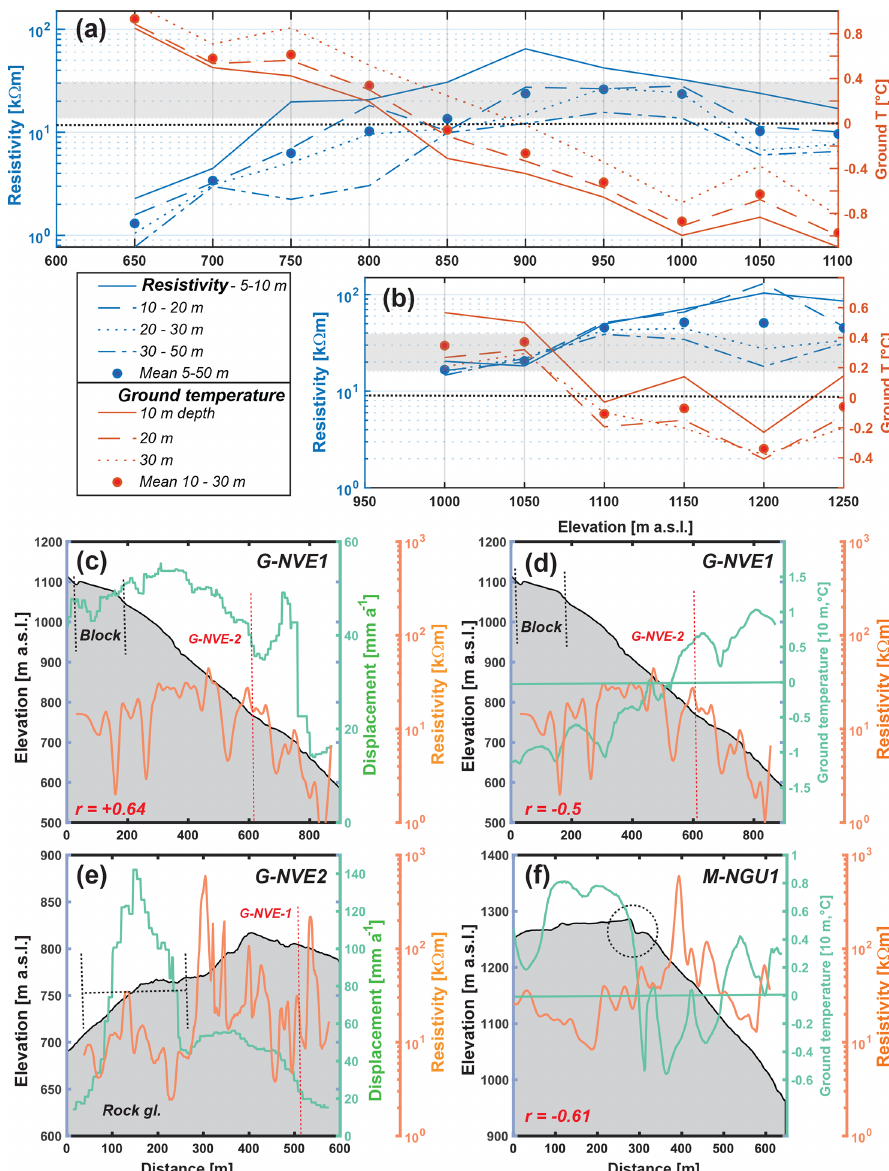
Figure 13. Relationship between resistivity, modelled ground temperature (GT) and rockslide displacement rates along selected profiles for Gámanjunni-3 and Mannen, binned in 50m intervals. At Mannen, poorer InSAR coverage restricted the analysis of the velocity–ERT relationship. The black dotted line indicates the modelled 0 ◦ C line, while the grey area indicates the electrical resistivity transition resolved from laboratory analysis (Fig. 3). (a) Relationship between modelled ground temperature in three depths and extracted electrical resistivity for four different depth areas for G-NVE1. The solid circles display averages over all depths. The graph confirms the transition area for permafrost around 800ma.s.l. (b) The same as (a) , but for Mannen (M-NGU). Here there is also a higher resistivity with lower temperatures, but the relationship is less clear. According to the modelling permafrost can be expected above 1100ma.s.l. (c) Relationship between elevation, displacement rates and electrical resistivity for G-NVE1. ERT and displacement rates co-vary, with a significant correlation of r = 0 . 64. The red line shows the crossing point for G-NVE2. (d) G-NVE1. Relationship between elevation, modelled GT and electrical resistivity. We observe a negative relation between GT and resistivity ( r = − 0 . 5). The red line shows the crossing point for G-NVE2. (e) Cross-profile G-NVE2 over the rock glacier (dotted line) and rockslide area at ca. 700ma.s.l. Resistivity is lower and displacement rates are much higher on the rock glacier than on the rockslide part, indicating different modes of movement (see main text). The red line shows the crossing point for G-NVE1 (f) M-NGU. Relationship between surface altitude, modelled GT and resistivity. We observe a negative relationship between GT and resistivity ( r = − 0 . 61), with lower GT and higher resistivity values along the upper part of the steep slope. The location of the back scarp of the unstable area is indicated with a